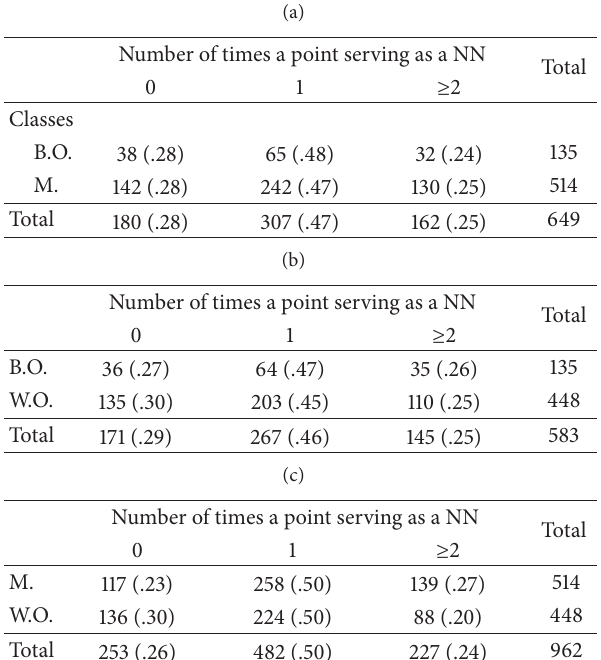
Table 17: The restricted NNCTs for each pair of species in the Lansing Woods data (i.e., only the points for the pair of species are considered, the other species is ignored). B.O. stands for black oaks and W.O. for white oaks.